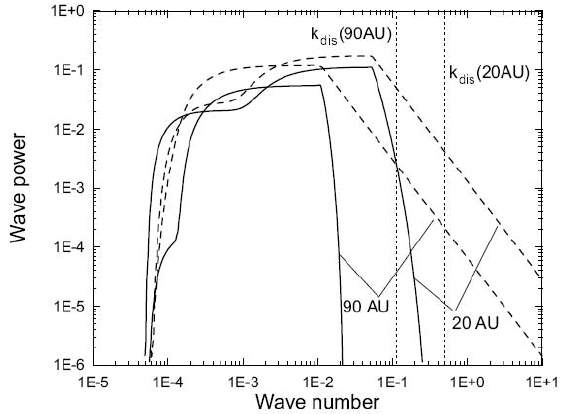
Fig. 2. The normalized wave power spectra ˜ W(k) = √ (e r 0 /(mcU)W(k) as functions of the normalized wavenum- ber ˜ k = kU/(cid:127) E as computed by Chalov et al. (2004). The solid lines are for the case that damping due to resonant interactions between the waves and pick-up protons is taken into account, while the dashed lines are spectral powers for vanishing damping. The vertical dotted lines show the solar wind proton dissipation wavenumbers.